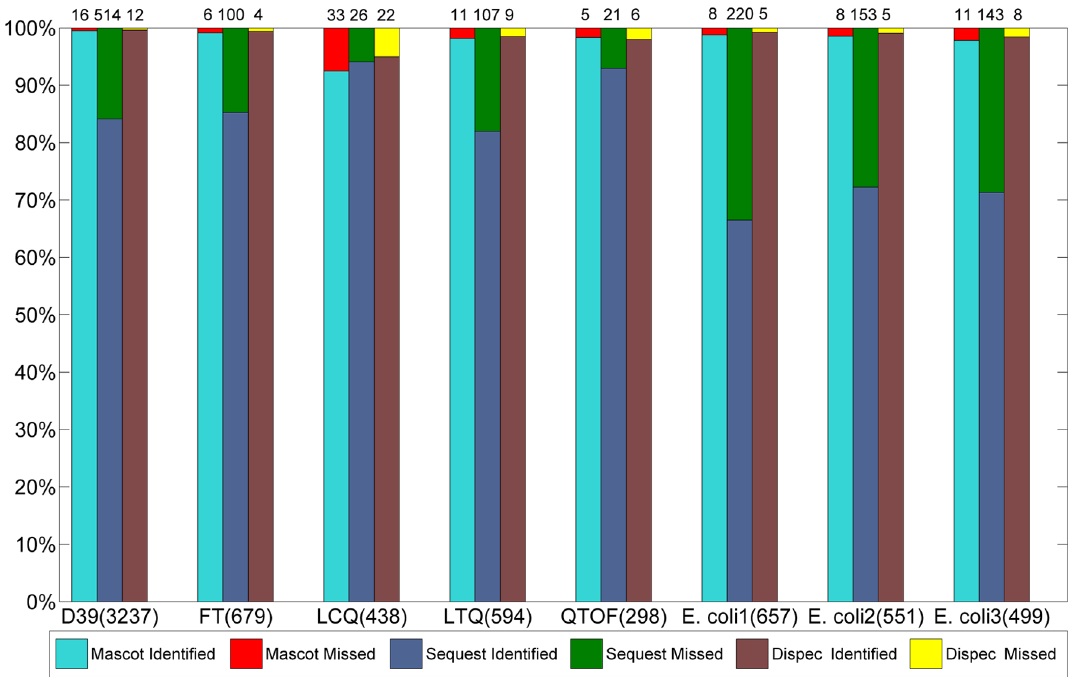
Figure 5. The high-confidence peptides of all three algorithms at 1% PSM-level FDR.